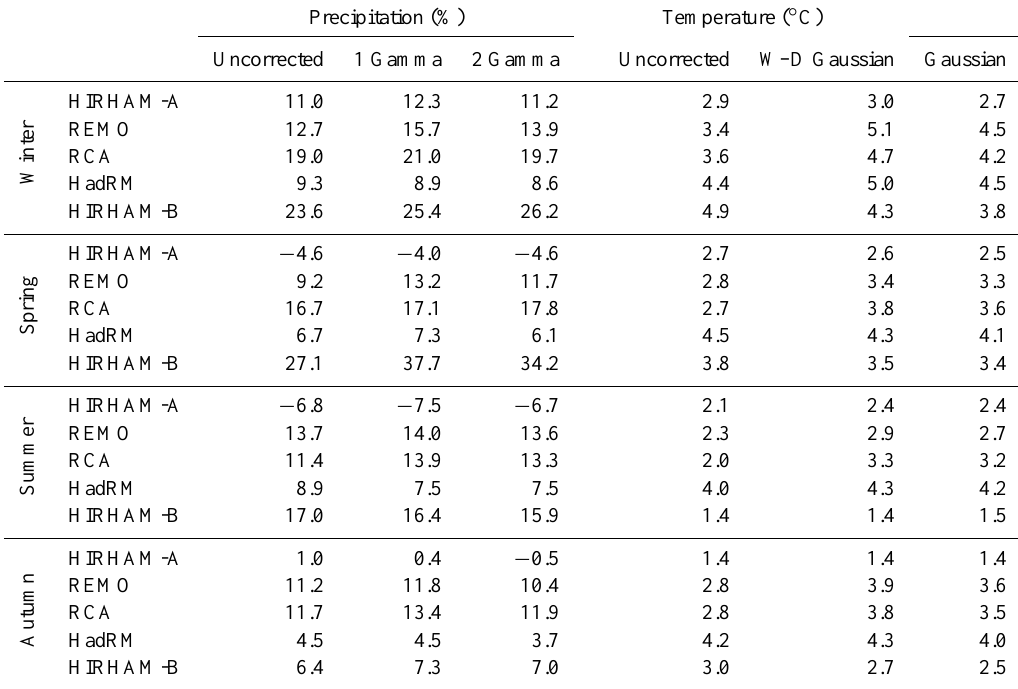
Table 3. Changes in uncorrected and DBS-adjusted RCM seasonal precipitation sums in % and daily mean temperatures as ◦ C between control (1961–2000) and scenario periods (2051–2090). Values are shown for winter and spring in Loimijoki catchment in southern